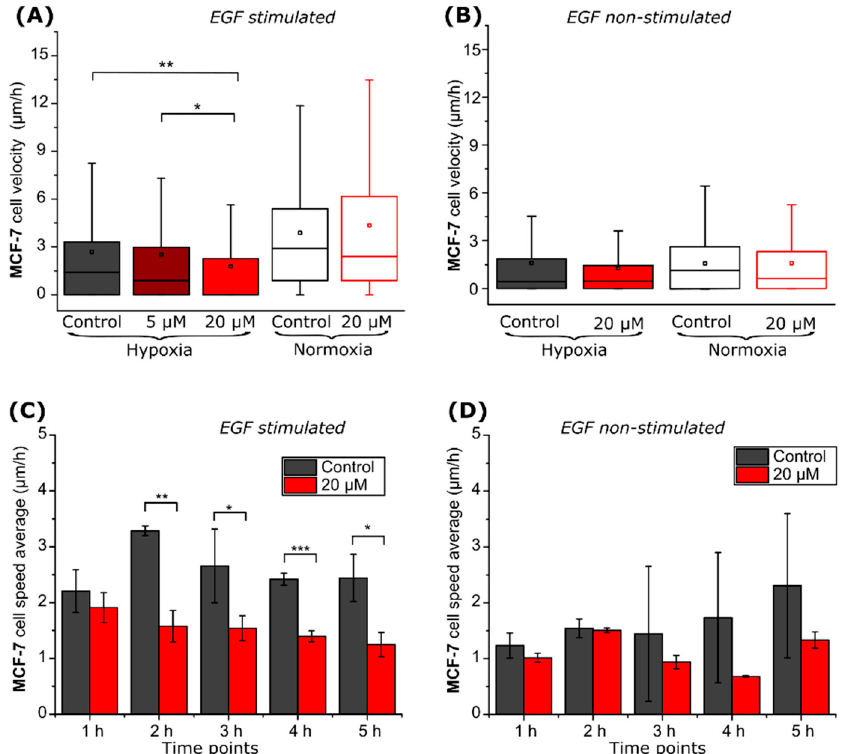
Figure 5. MCF-7 cell migration properties. Control and VD11-4-2 (5, 20 µM)-treated MCF-7 cell ve- locities ( A , B ) and hypoxic cell speed changes during the time ( C , D ), then cells were stimulated ( A , C ) and non-stimulated with EGF ( B , D ) (* p < 0.05; ** p < 0.01; *** p < 0.001).